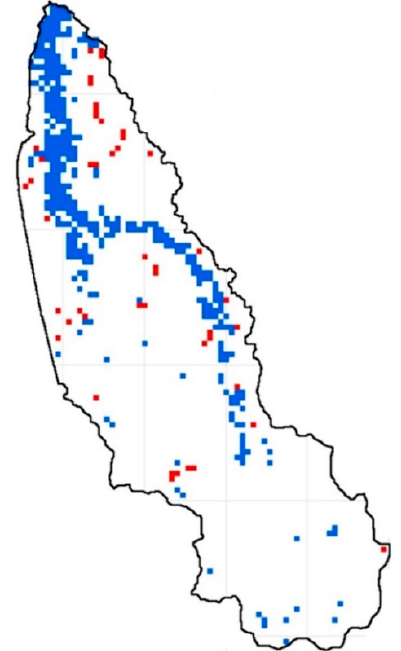
Figure 12. Santa Catalina stream basin map showing the concordance between the simulated (CTSS8 model) and the observed (SPOT image) water impounded areas for the event registered on 05/17/2012. The SPOT image was taken on 05/18/2012. The blue pixels indicate a concordance, whereas the red pixels depict a lack of concordance.